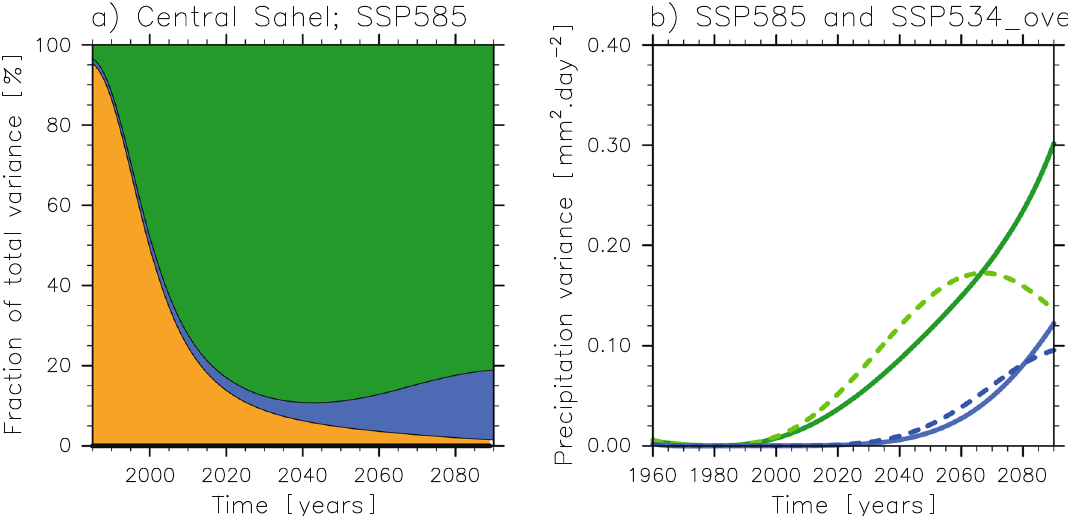
Fig. 5 Reducing uncertainty in central Sahel precipitation change. a Fraction of the total uncertainty in 21-year running mean precipitation, as de fi ned from the sum of fast (green), slow (blue) and internal climate variability (orange) uncertainties, for central Sahel precipitation. Fast and slow uncertainties are de fi ned from the inter model variance in fast and slow components of precipitation change, fi rst smoothed by fi tting a fourth-order polynomial. Internal climate variability is de fi ned from multi model average of 21-year precipitation variance, fi rst computed for each model, using pre-industrial control simulations. Values are plotted at the central year of the 21-year moving window. b Absolute inter model variance in fast response (green) and slow response (blue) for the SSP585 (continuous line) and SSP534_over (discontinuous line) emission scenarios. 26 models are used in a and 7 models are used in b